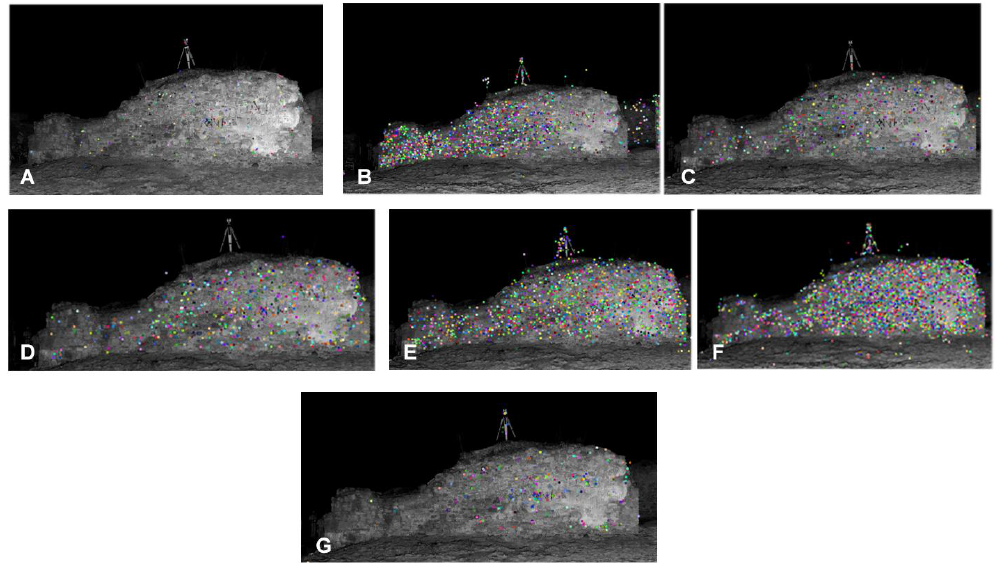
Figure.4 Points detected by means of the following detectors: A) BRISK, B) FAST, C) MSER, D) SIFT, E) SURF, F) ASIFT and G) CenSurE (STAR).